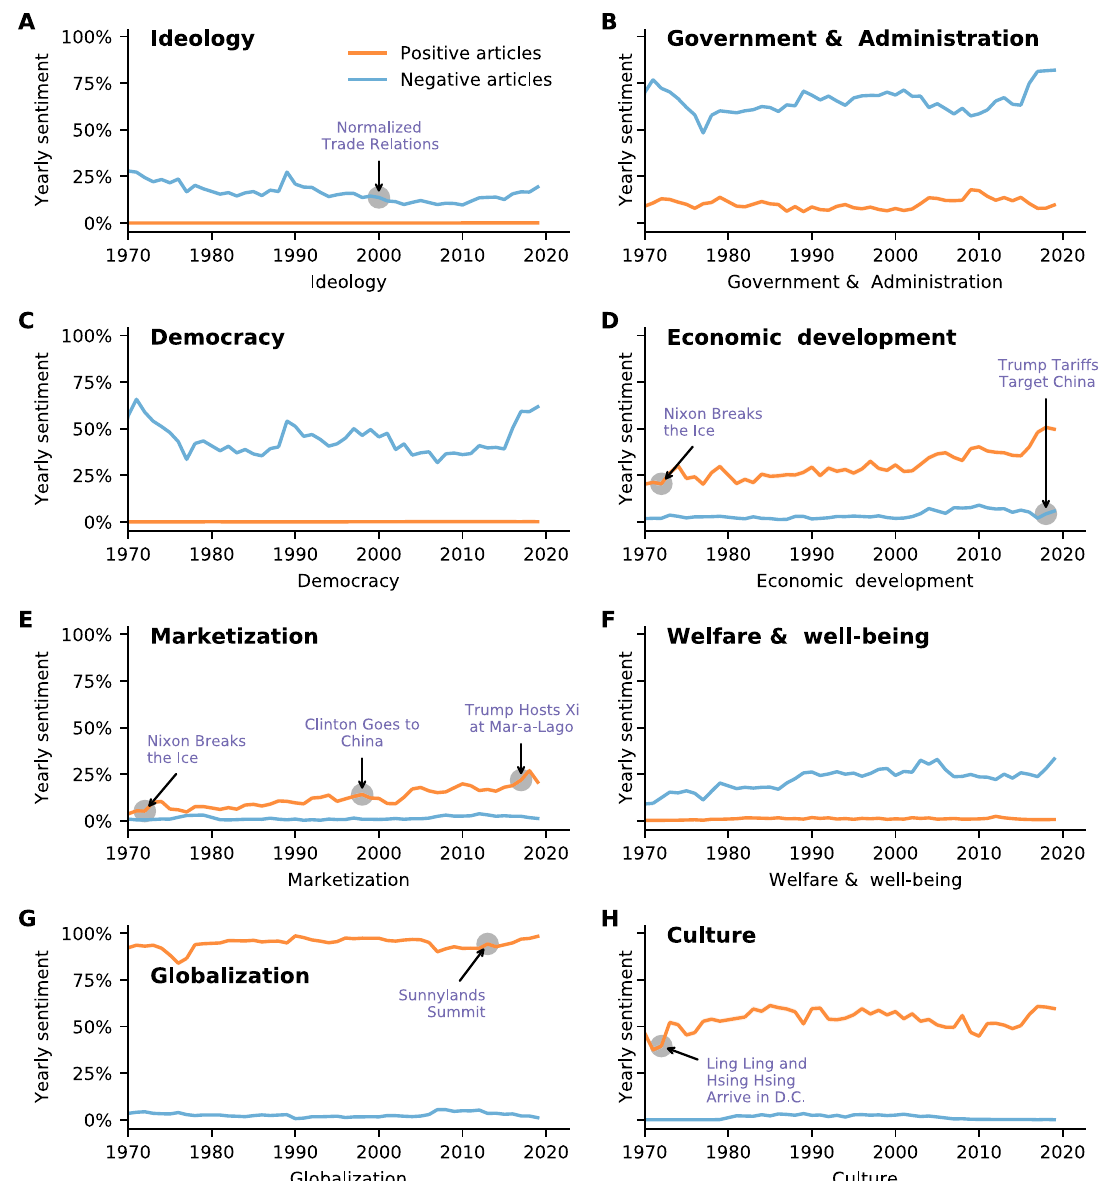
Fig. 3 Sentiments on The New York Times on China in eight topics from 1970 to 2019. The panel reports the trend of yearly media attitude toward China in ( A ) ideology, ( B ) government & administration, ( C ) democracy, ( D ) economic development, ( E ) marketization, ( F ) welfare & well-being, ( G ) globalization, and ( H ) culture. The media attitude is measured as the percentages of positive articles and negative articles, respectively. US – China relation milestones are marked as gray dots. The New York Times express diverging but consistent attitudes in the eight domains, with negative articles consistently common in ideology, government, democracy, and welfare, and positive sentiments common in economic, globalization, and culture. Standard errors are too small to be visible (below 1.55% in all topics all